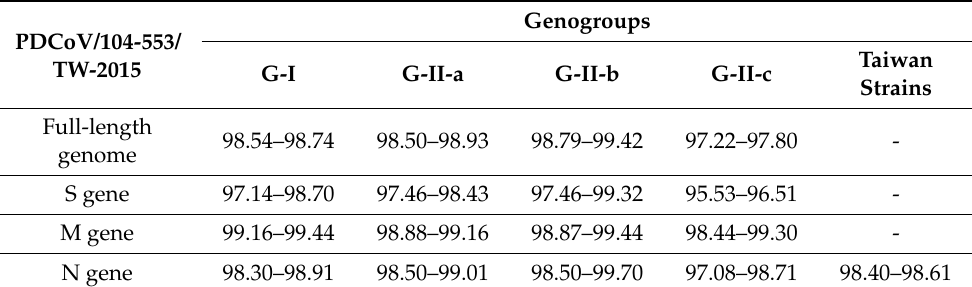
Table 1. Nucleotide identities (%) among porcine deltacoronavirus strains from Taiwan and four different genogroups defined in the present